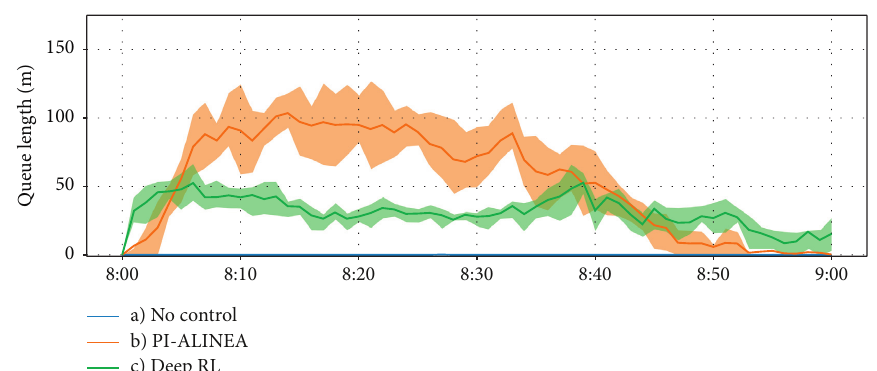
Figure 11: Queue length at the